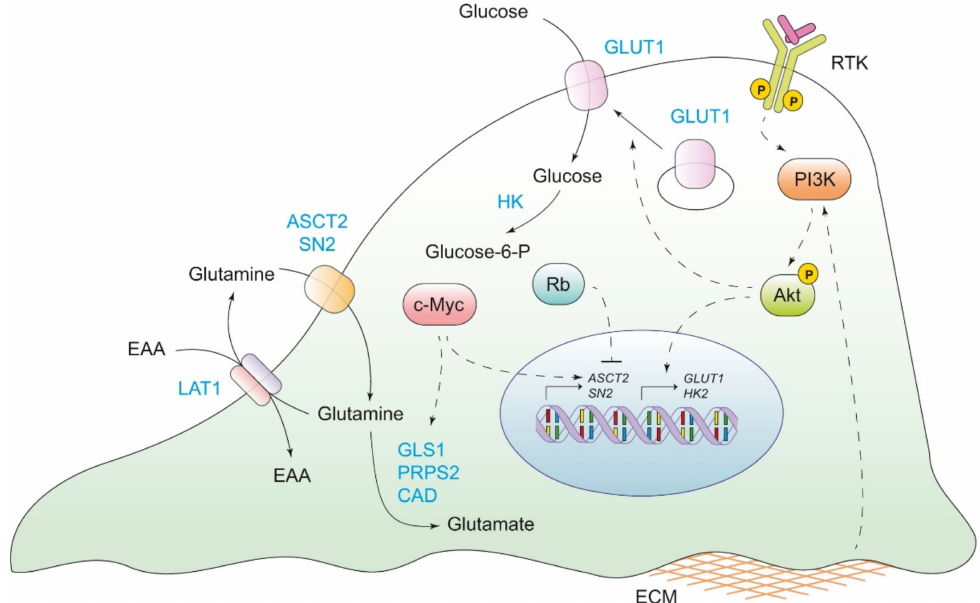
Figure 1. Deregulation of glucose and amino acids uptake in cancer cells. Solid arrows represent the movement of metabolites and proteins or the metabolic reactions. The dashed arrows indicate either positive or negative regulatory effects on signaling pathways in cancer cells. RTK: receptor tyrosine kinase; GLUT1: glucose transporter 1; ASCT2/SN2: glutamine transporter; LAT1: neutral amino acid transporter; EAA: essential amino acids; GLS1: glutaminase 1; PRPS2: phosphoribosyl pyrophosphate synthetase 2; CAD: carbamoyl-phosphate synthetase 2; HK: hexokinase; ECM: extracellular matrix. Image reproduced from [22] with permission from Elsevier. Copyright ©